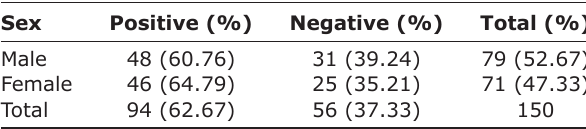
Table-5: Sex distribution of Campylobacter isolates in human fecal samples from Zuru Kebbi